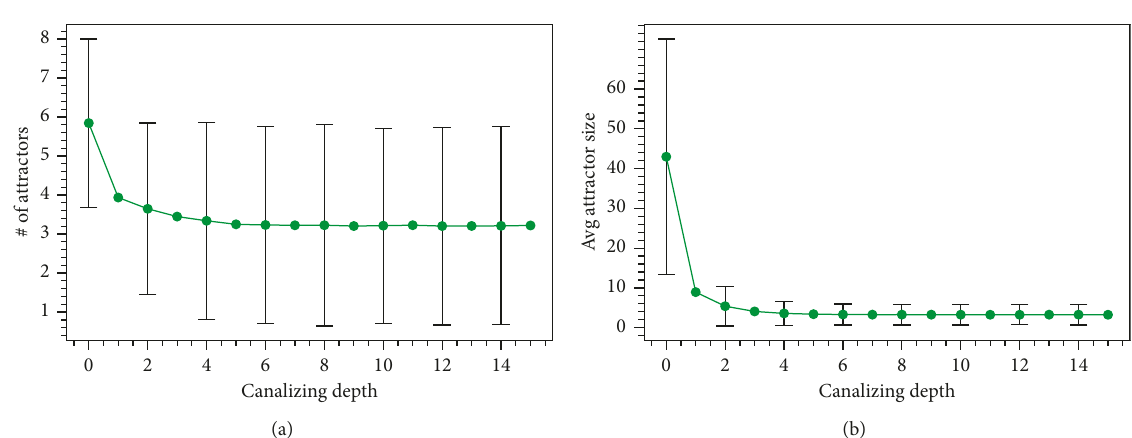
Figure 1: Dependencies of the sample means of N ( f ) and AS ( f ) on the canalizing depth. (a) The number of attractors N ( f ) . (b) Average size of an attractor AS ( f ) .